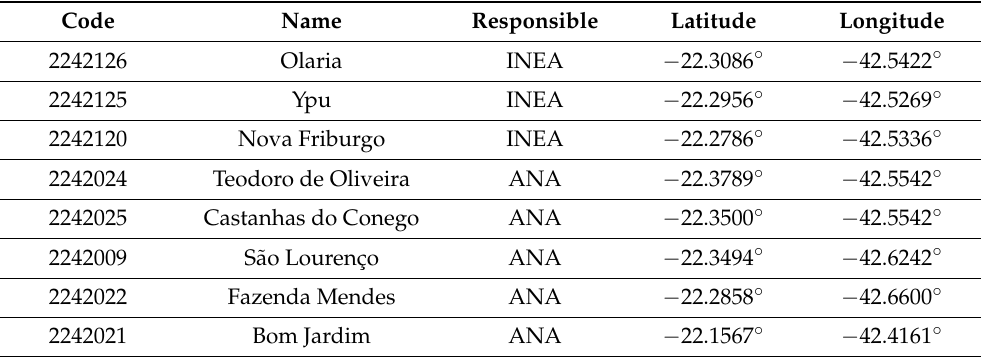
Table 1. Rainfall Stations.